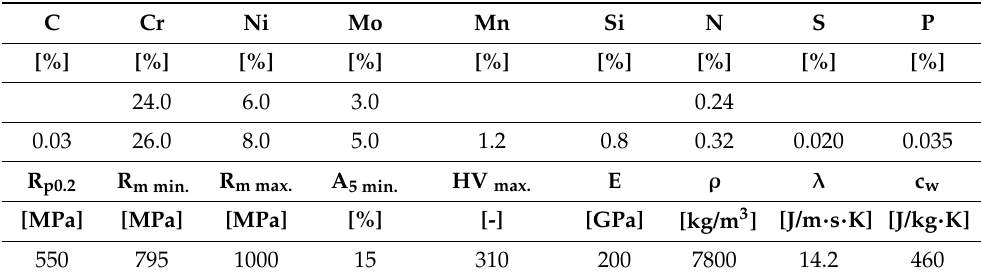
Table 1. The chemical constitution and mechanical properties of stainless steel type